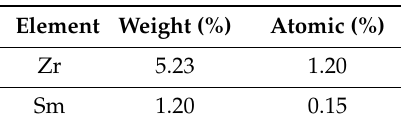
Table 6. Quantitative EDS analysis results obtained from point 2 on the surface of the sample presented in Figure 8b (data only for Zr and